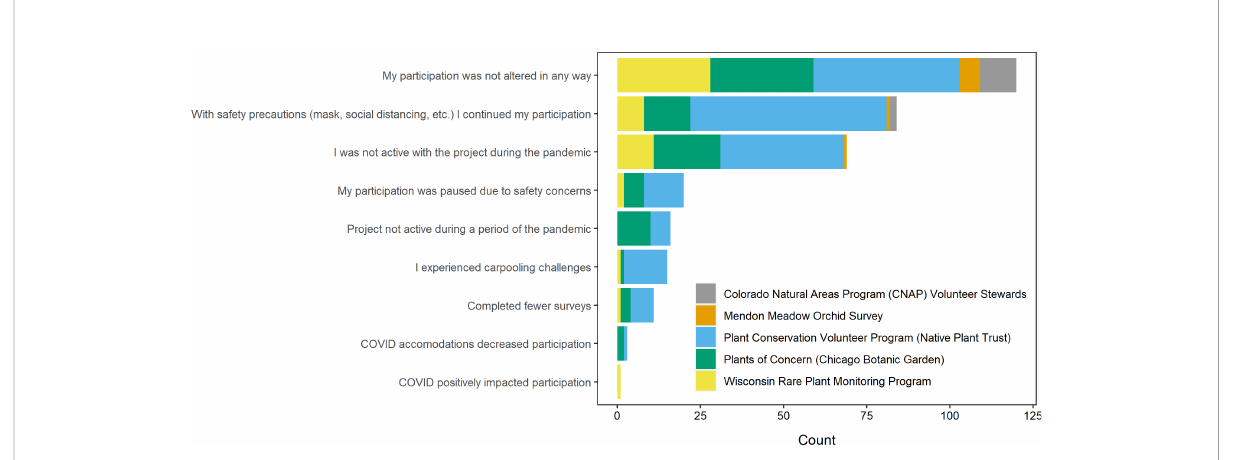
FIGURE 9 Impact of the COVID-19 pandemic on project